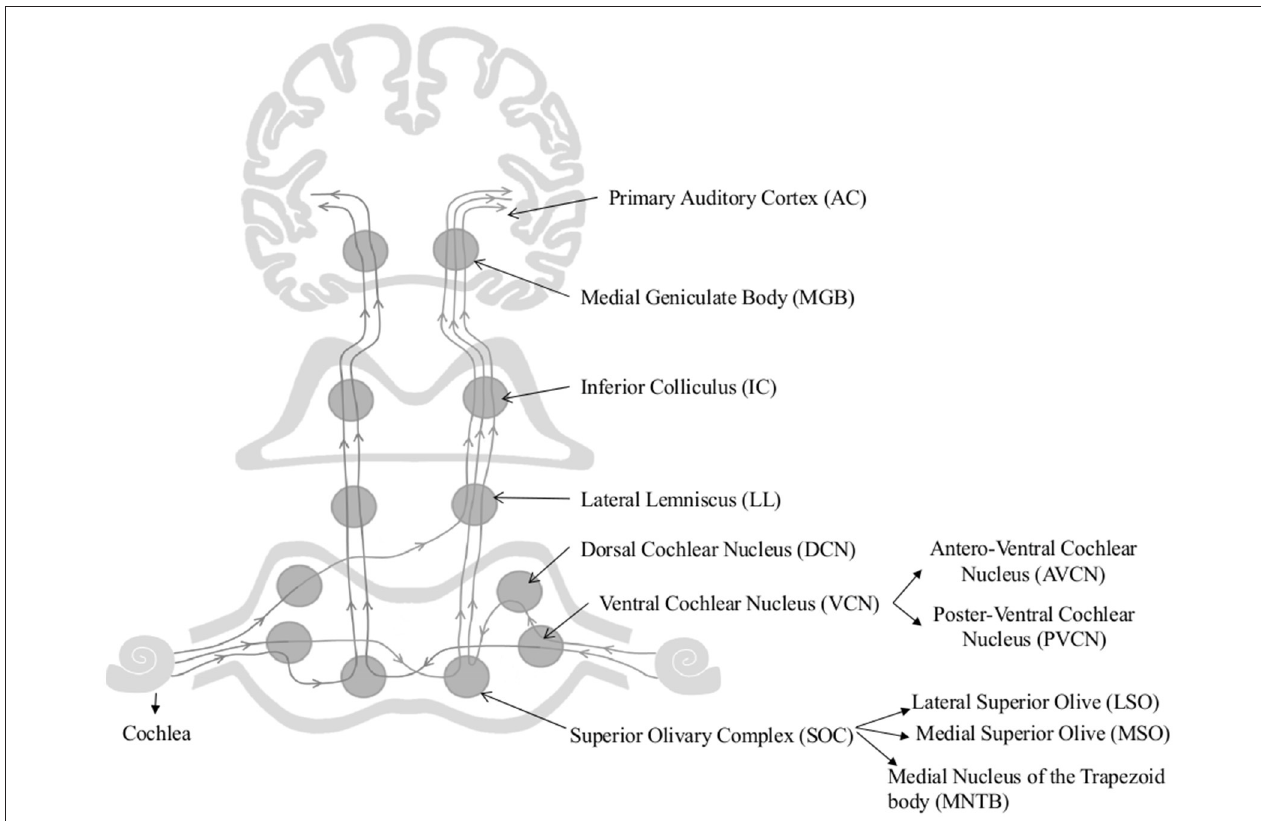
FIGURE 1 | Schematic diagram of the auditory pathway. This schematic diagram represents ipsi and contralateral auditory pathways from cochlea to the auditory cortex. Main nuclei of the central auditory pathway, namely Superior Olivary Complex (SOC), Dorsal and Ventral Cochlear Nuclei (DCN & VCN), Lateral lemniscus (LL), Inferior Colliculus (IC), Medial Geniculate body (MGB), and Primary Auditory Cortex (AC) are shown in the